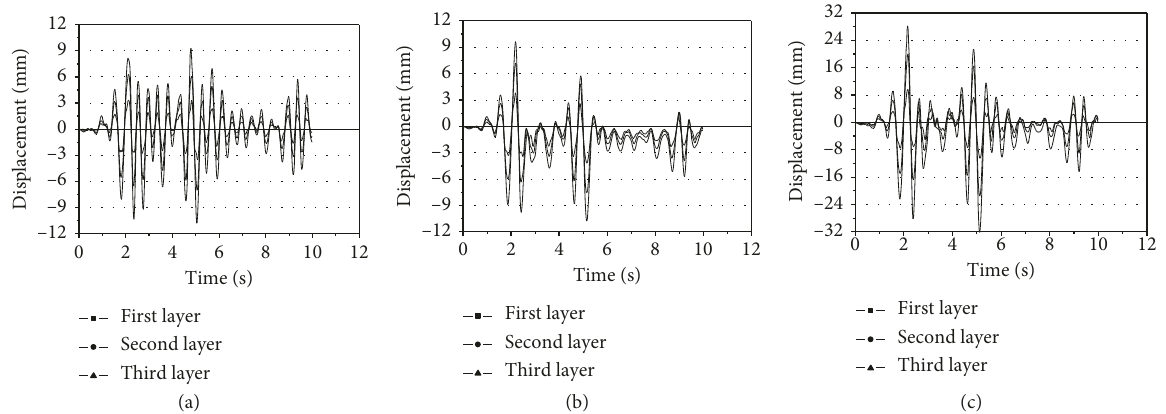
Figure 5: Displacement time-history curves of the prestressed fabricated concrete frame. (a) PGA � 2 × 34gal. (b) PGA � 3 × 34gal. (c) PGA � 6 × 34gal.